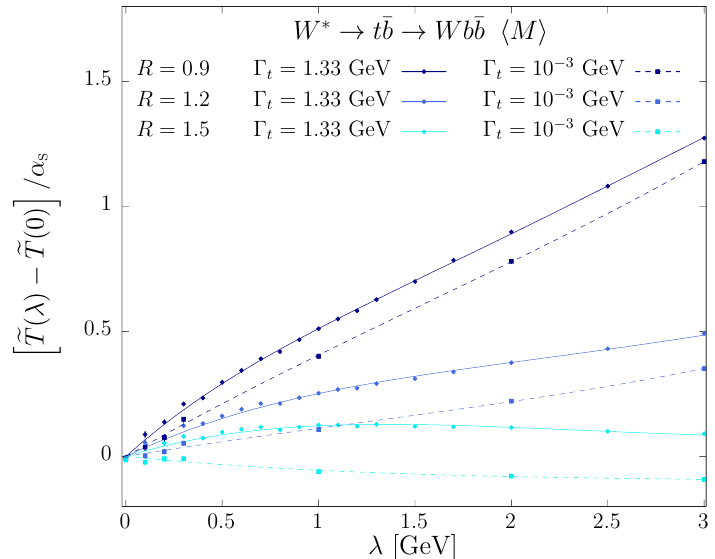
Figure 9 . Small (cid:21) behaviour of e T ( (cid:21) ) for the averaged reconstructed-top mass for large values of the jet radius R , for two di(cid:11)erent values of the top decay width, (cid:0) t = 1 : 3279 GeV (solid lines) and (cid:0) t = 10 (cid:0) 3 GeV (dashed lines). The dashed lines are a cubic (cid:12)t of the computed points. The solid lines are the same displayed in (cid:12)gure